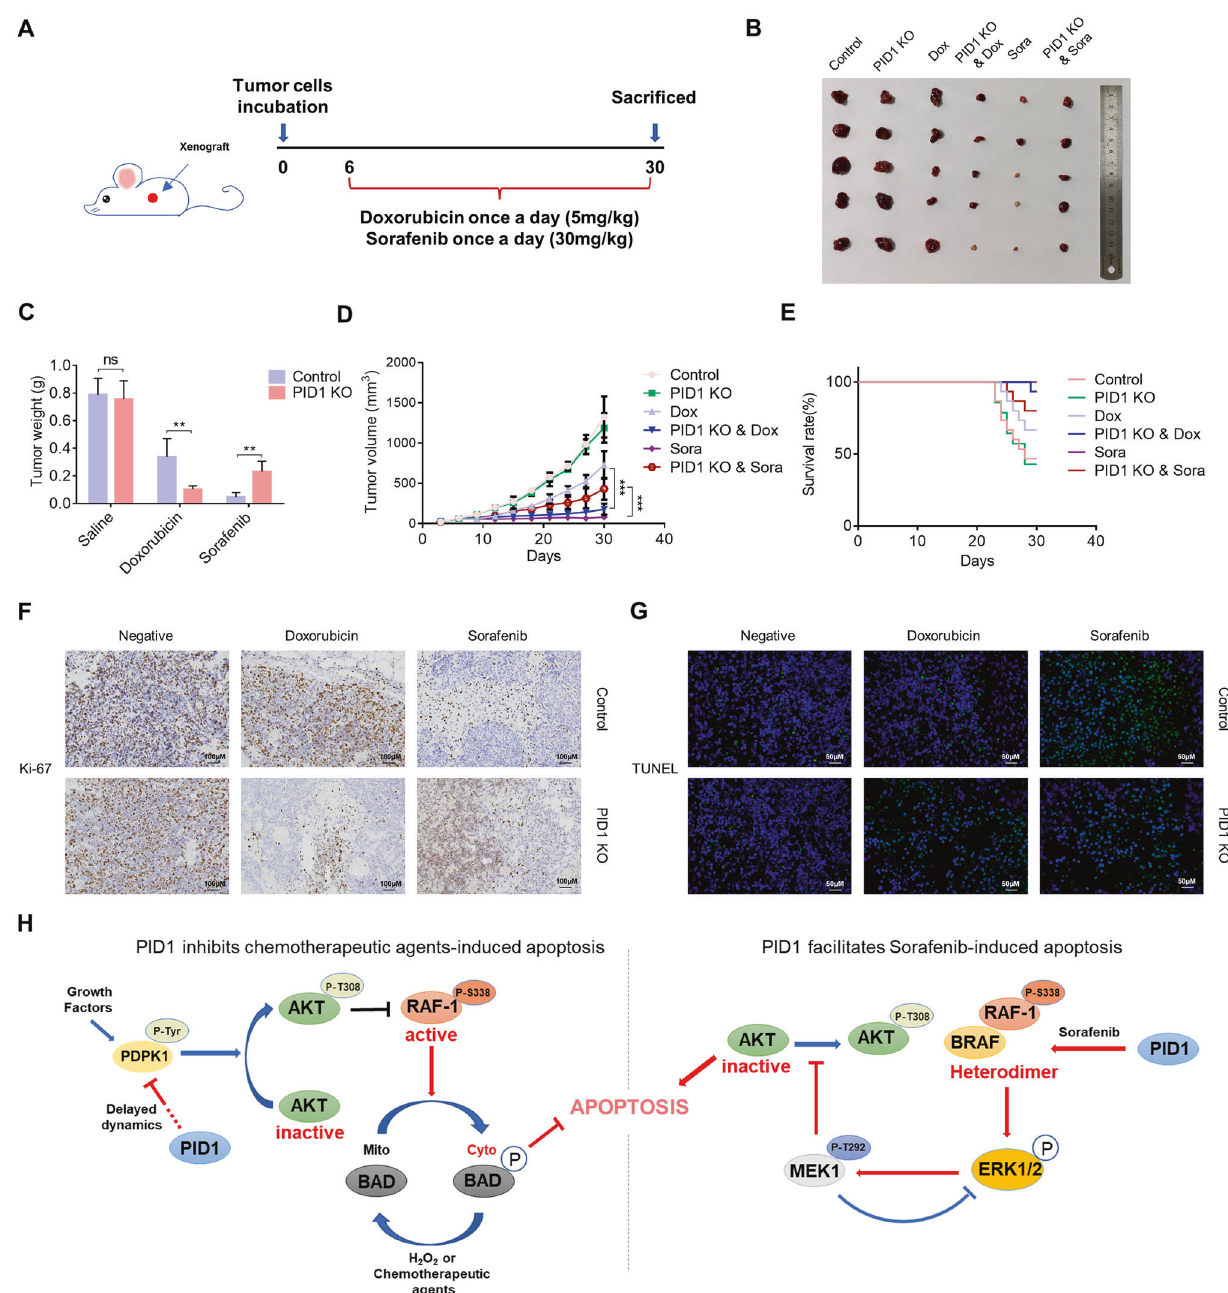
Fig. 7 PID1 reduced ef fi cacy of Doxorubicin but facilitated Sorafenib-induced apoptosis in vivo. A The diagram of therapy design. Hep3B cells with or without PID1 knockout were subcutaneously inoculated in the right fl anks of mice. Mice were randomly divided into six groups when they fi rst developed a mass at day 6 ( n = 15). Doxorubicin and Sorafenib were given intraperitoneally with a daily dosage of 5 mg/kg for Doxorubicin and 30 mg/kg for Sorafenib until the end point at day 30. B Photographs illustrating tumors in xenografts of Hep3B cells with or without knockout upon indicated treatments ( n = 5). C Weight of xenograft tumors. D Growth curves of xenograft tumors upon indicated treatments. E Survival curve showed that PID1 de fi ciency increased survival rate upon Doxorubicin treatment but declined ef fi cacy of Sorafenib. F Ki-67 staining of tumor slices. G TUNEL staining of tumor slices. H Model for the mechanism by which PID1 inhibits conventional chemotherapeutic agents-induced apoptosis but promotes Sorafenib-induced apoptosis. probe for 30 min at 37 °C in the dark, washed three times with PBS and probes for 30 min at 37 °C in the dark and analyzed by fl ow cytometric resuspended in PBS for analysis of ROS using cytometry analysis. analysis and Red/Green ratio was calculated. Thereafter, mean fl uorescence intensity (MFI) was calculated. Intracellular ROS assay Western blot analysis The cultured cells were collected by combing fl oating cells in the medium The total protein was extracted from cells using RIPA lysis buffer in the and adherent cells were treated with 0.25% trypsin, then washed three presence of protease inhibitor cocktail and phosphatase inhibitor cocktail. times with cold PBS. The cells were subsequently stained with H 2 DCFDA